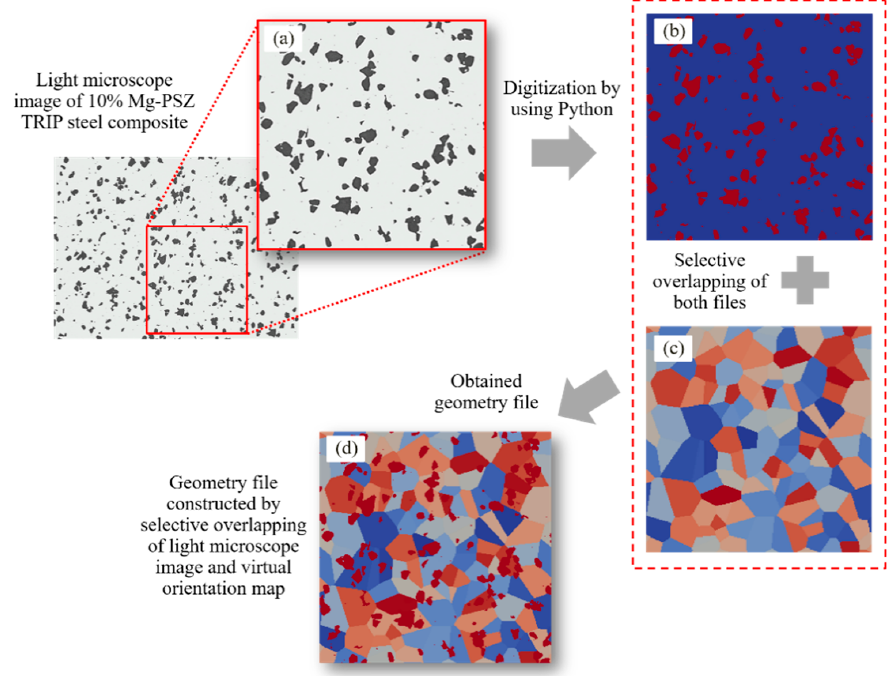
Figure 2. Metal Matrix Composite (MMC) and its digitization into a geometry file for DAMASK simulation: ( a ) light microscope image of the MMC microstructure at 200 × ; ( b ) digitized light microscope image with identified phases; ( c ) virtual construction of random microstructure using Voronoi tessellation criteria; and ( d ) merged images for the construction of final geometry file with phase and orientation information.